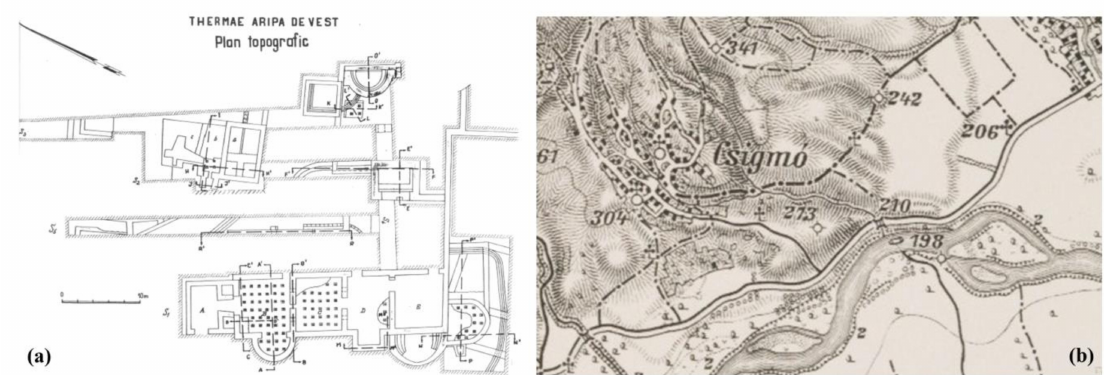
Figure 10. Examples of cartographic data that enhanced the knowledge about the studied archaeological sites: ( a ) The fort of Micia – topographic map of the west wing thermae © [56]; ( b ) The fort of Germisara – 3rd Austrian topographic survey published in 1910 (image source: http: // geo--spatial.org).